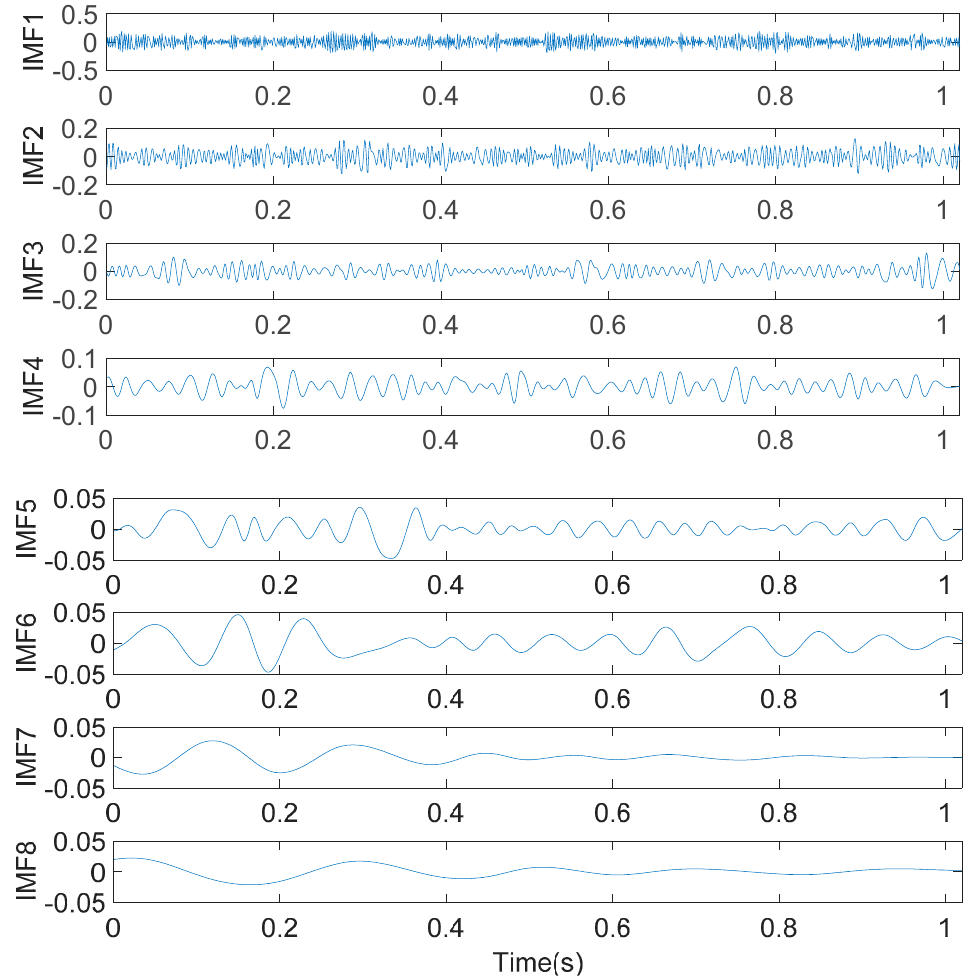
Figure 4. The time-domain diagrams of eight Intrinsic modal Function (IMF) components.